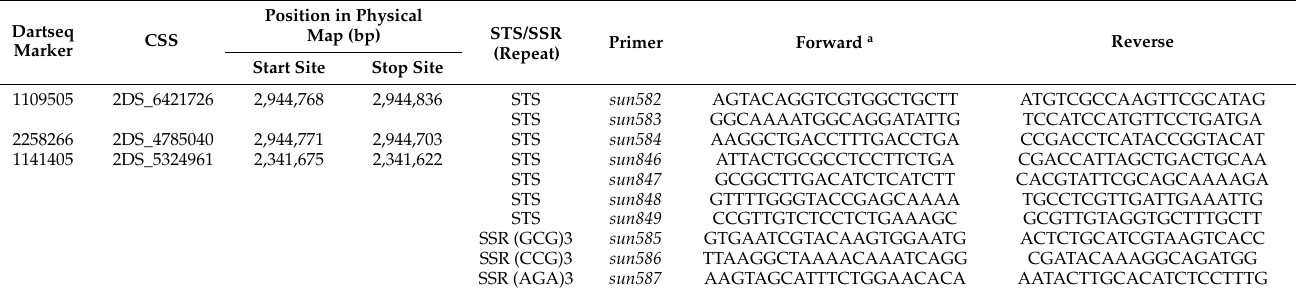
Table 1. Primer sequences of STS and SSR markers derived from the wheat chromosome survey sequences (CSS) in the region spanning